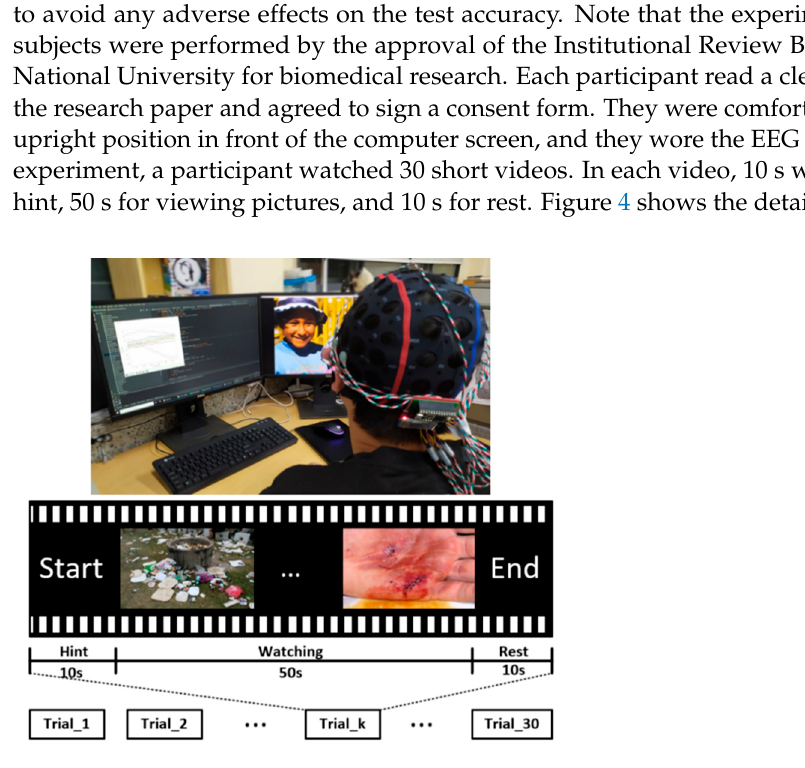
Figure 4. Protocol of the EEG experiment.